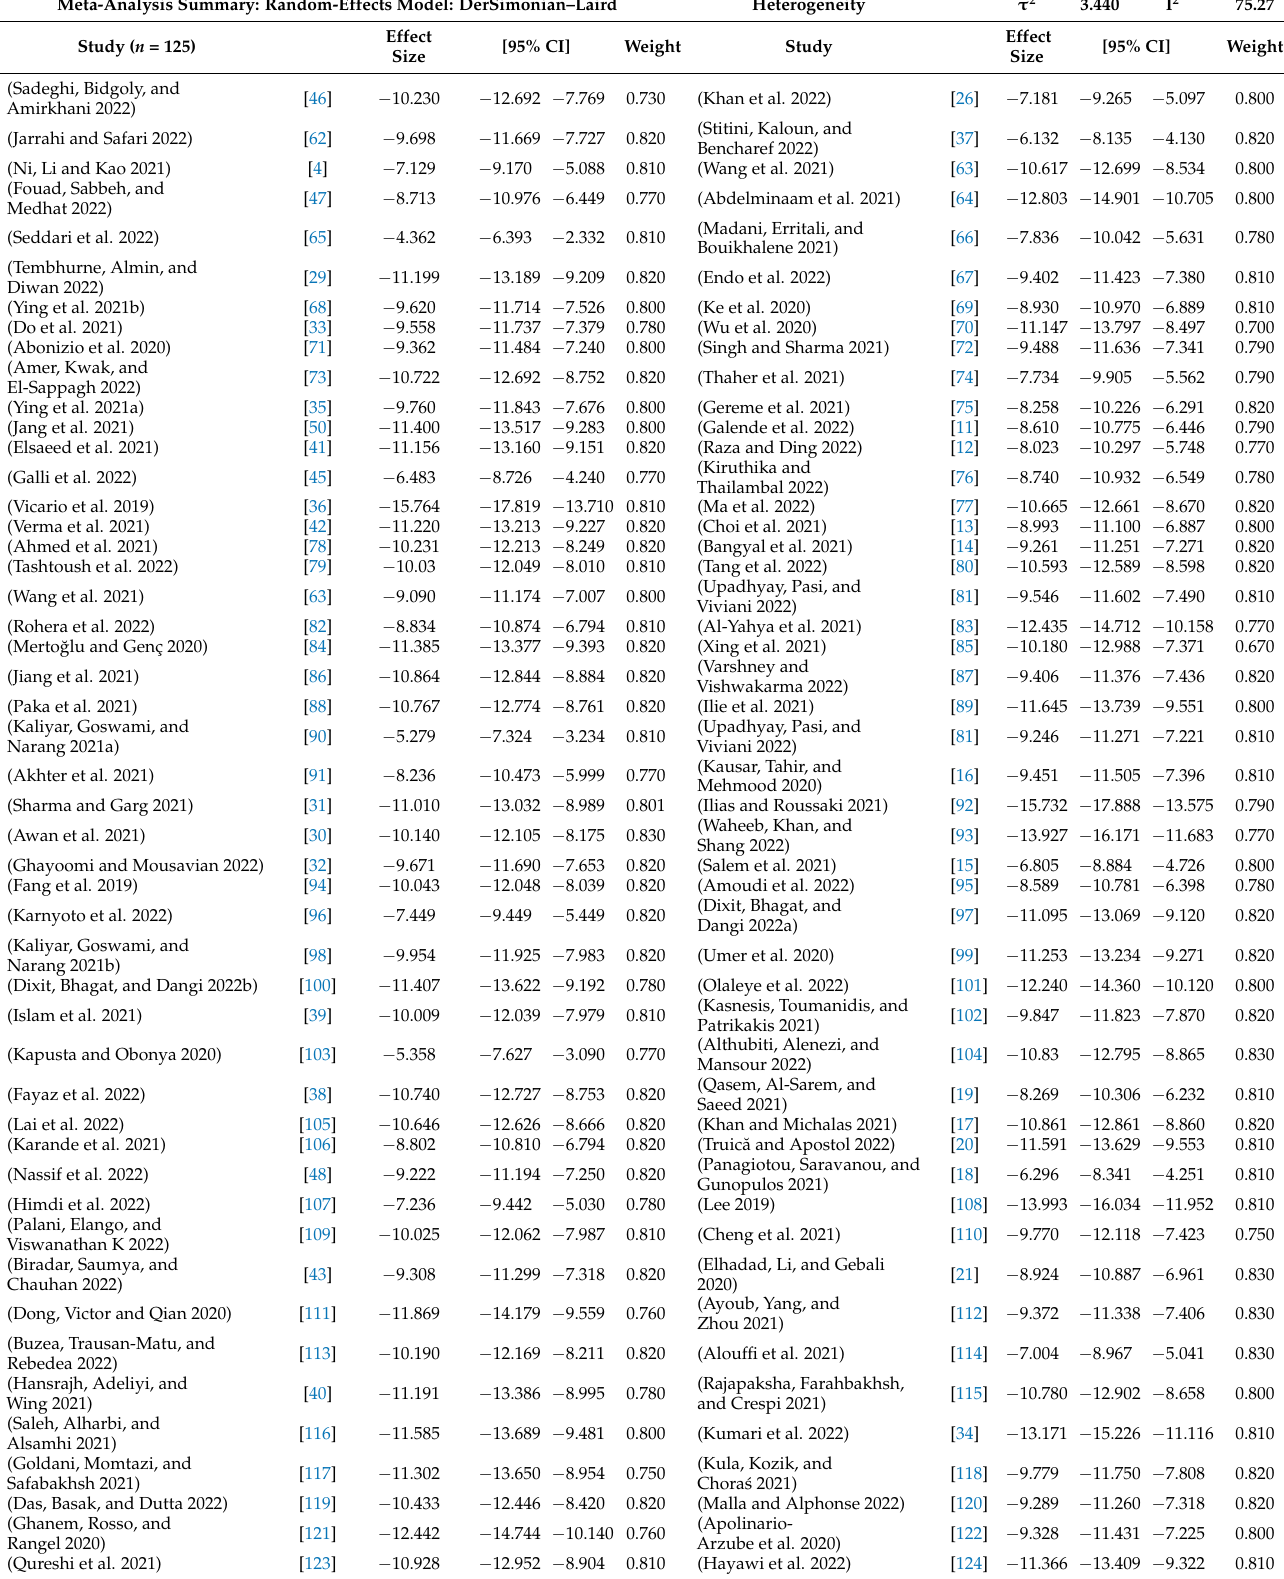
Table 3. Meta-analysis summary: random-effects model